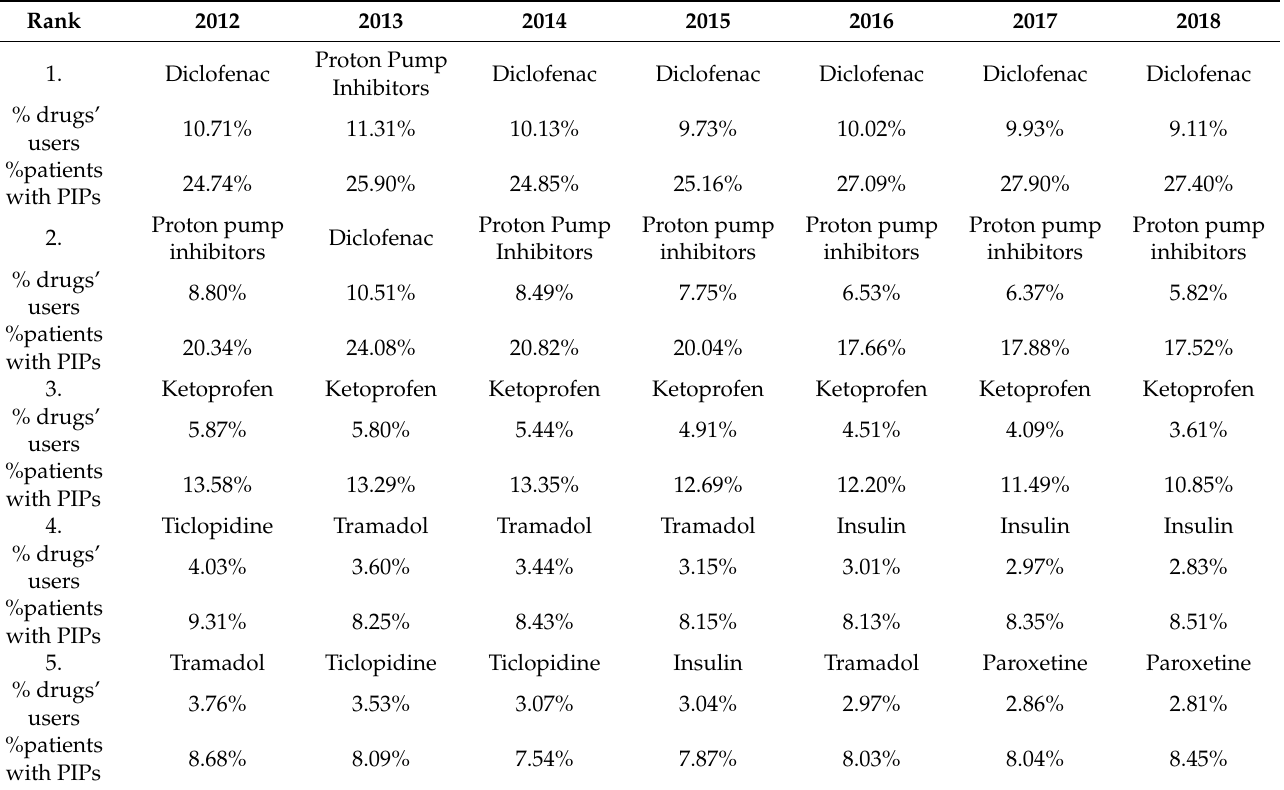
Table 2. Characteristics of outpatients older than 65 years exposed to at least one potentially inappro- priate prescription in Piedmont in the period